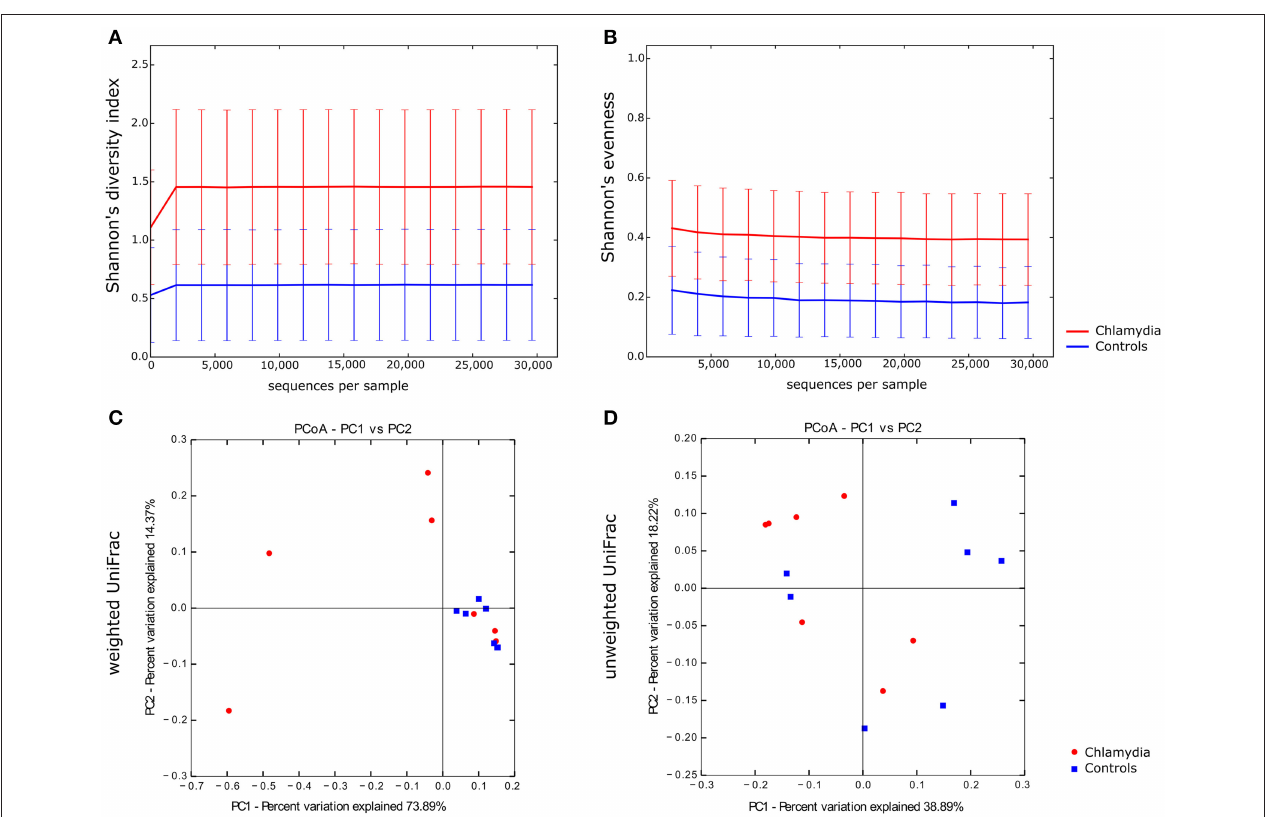
FIGURE 3 | Alpha and beta diversity of the cervical microbiota from C. trachomatis positive women and healthy controls. Alpha rarefaction curves of Shannon’s diversity index (A) and Shannon’s evenness (B) . Samples were rarefied to the smallest observed number of reads (29,613). Principal coordinate analysis (PCoA) plots of weighted (C) and unweighted (D) UniFrac distances. Each dot represents the cervical bacterial community composition of one chlamydia-positive woman or healthy control. Groups were compared using Monte-Carlo permutations for alpha diversity and Adonis for beta